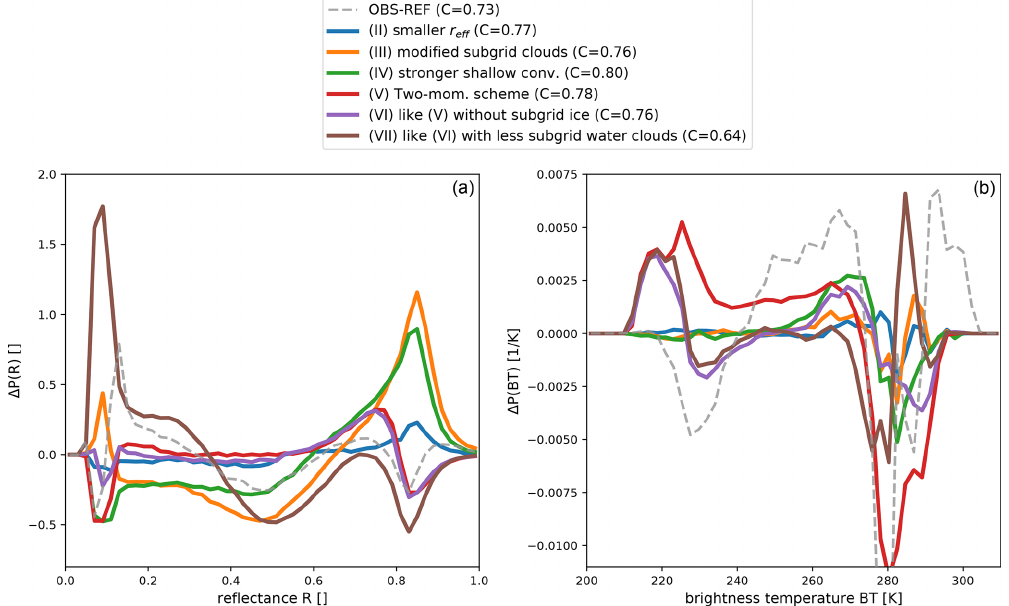
Figure 11. Differences in the 0.6µm SEVIRI solar reflectance (a) and 10.8µm SEVIRI brightness temperature (b) PDFs between perturbed model simulations and the reference run. The perturbed model settings are (II) increased cloud droplet number concentration (smaller effec- tive radius) due to increased updraught velocity at activation, (III) modified distribution of turbulent subgrid liquid clouds (less and thicker subgrid clouds), (IV) stronger shallow-convection parameterisation due to doubled thickness of the thickest unresolved cloud, (V) simu- lation with the two-moment scheme, (VI) is like (V) but without subgrid-ice clouds, and (VII) is like (VI) but with a reduced number of subgrid-scale liquid clouds. For comparison, the difference between the observations and the reference run histogram is also shown (dashed